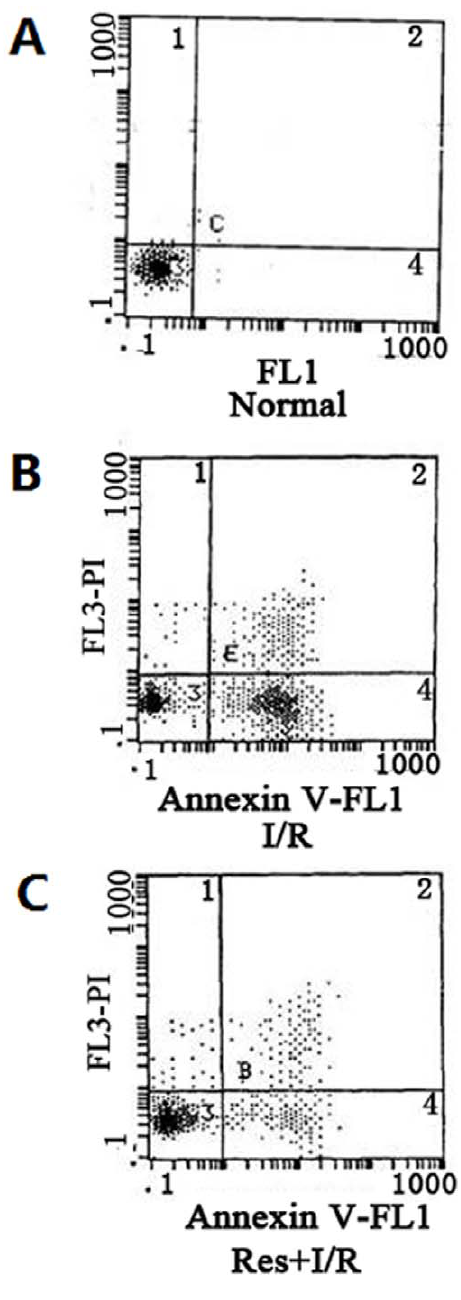
Figure 3. Assay of cardiomyocytic apoptosis with flow cytometry. (A) In the normal group, most of the cells lied in left lower quadrant, which indicated that the cells were viable. (B) In the I/R group, the number of cells in the right lower quadrant increased obviously compared with that in (A), which suggested that I/R injury induced apoptosis. (C) In the Res + I/R group, the number of cells in the right lower quadrant decreased dramatically compared with that in (B), which suggested that Res lowered cell apoptosis triggered by I/R.